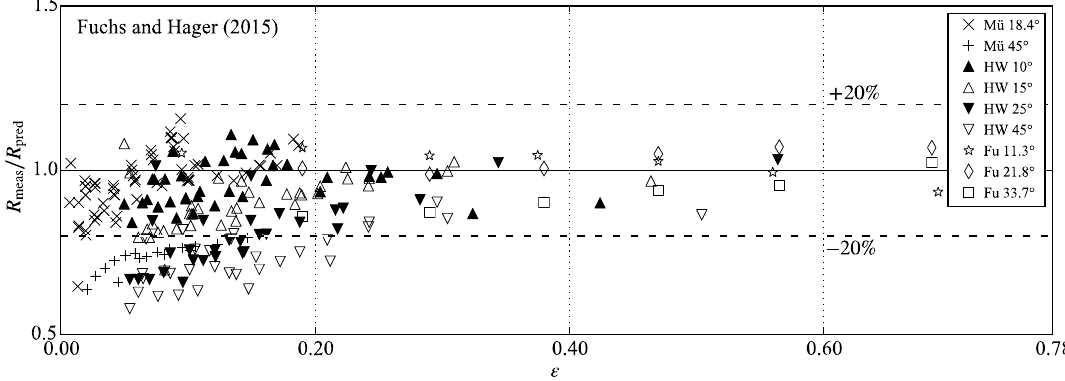
Figure 7. Measured over predicted (Equation (4) by Fuchs and Hager [15]) runup height R meas / R pred versus relative wave crest amplitude ε for experiments from data sources from Müller (Mü) [7] (without β = 90°), Hall and Watts (HW) [14], and Fuchs (Fu) [20].